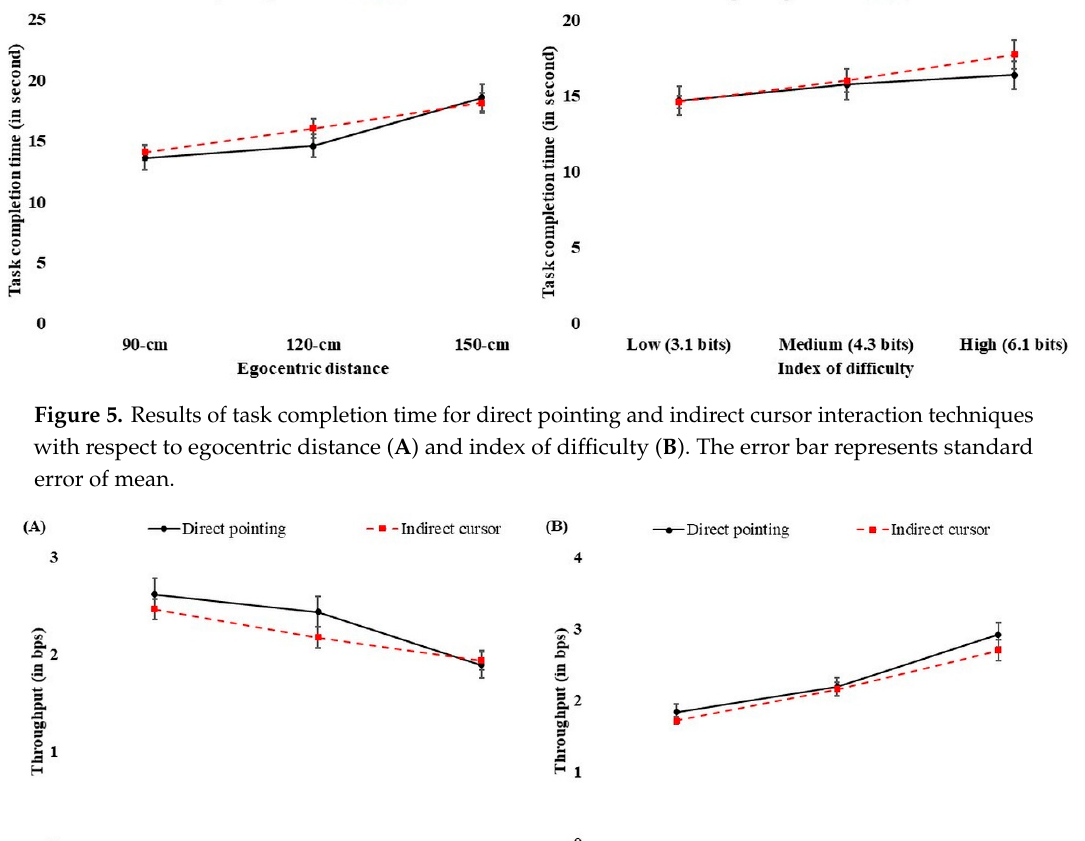
Figure 5. Results of task completion time for direct pointing and indirect cursor interaction techniques with respect to egocentric distance ( A ) and index of difficulty ( B ). The error bar represents standard error of mean.